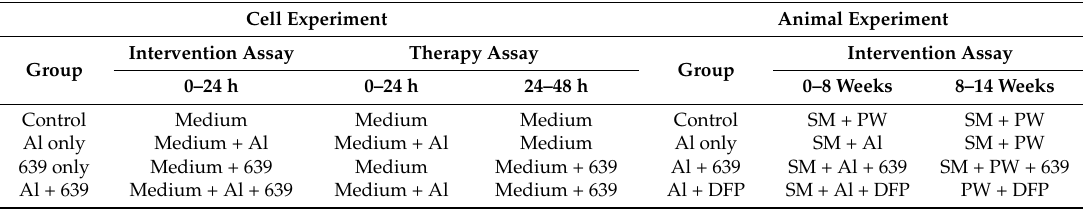
Table 1. The design of cell and animal